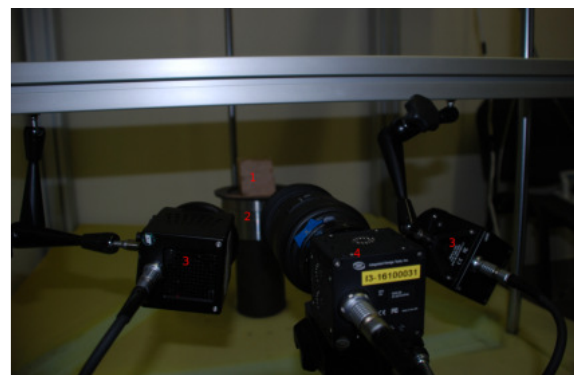
Figure 2. Drop tower setup (1 - specimen, 2 - im- pactor, 3 - flash-illumination, 4 - high-speed camera).